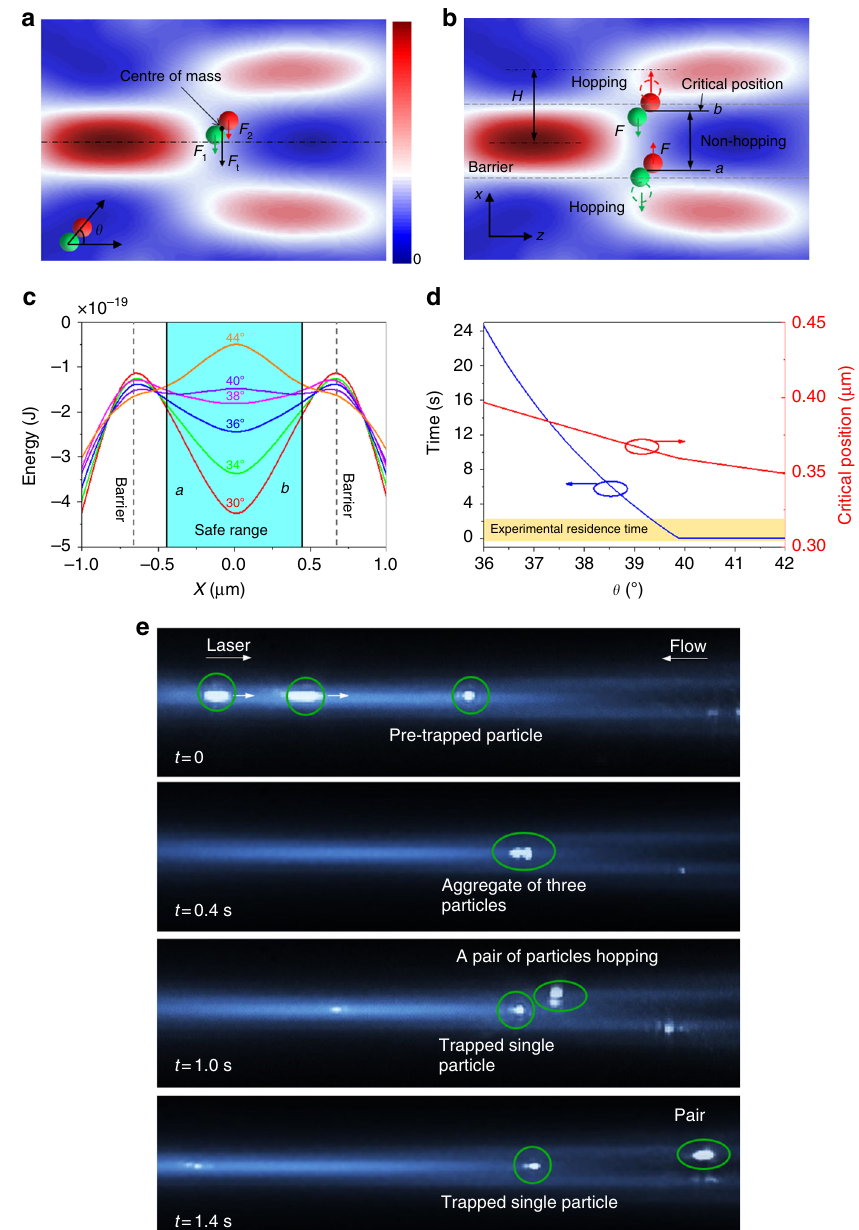
Fig. 4 Particle hopping induced by particle aggregation. a Model for calculating mean fi rst passage time of the particle in the potential well. b Illustration of hopping of the particle pair between adjacent hotspots. c Potential wells of total force F t plotted along x -axis at y = 0 and z = 20 μ m with different contact angles. d Calculated mean fi rst passage time of the red particle varies with contact angle θ . Experimental residence time is distributed in the yellow area. e Experimental demonstration of the particle hopping induced by particle aggregation in the opto fl uidic